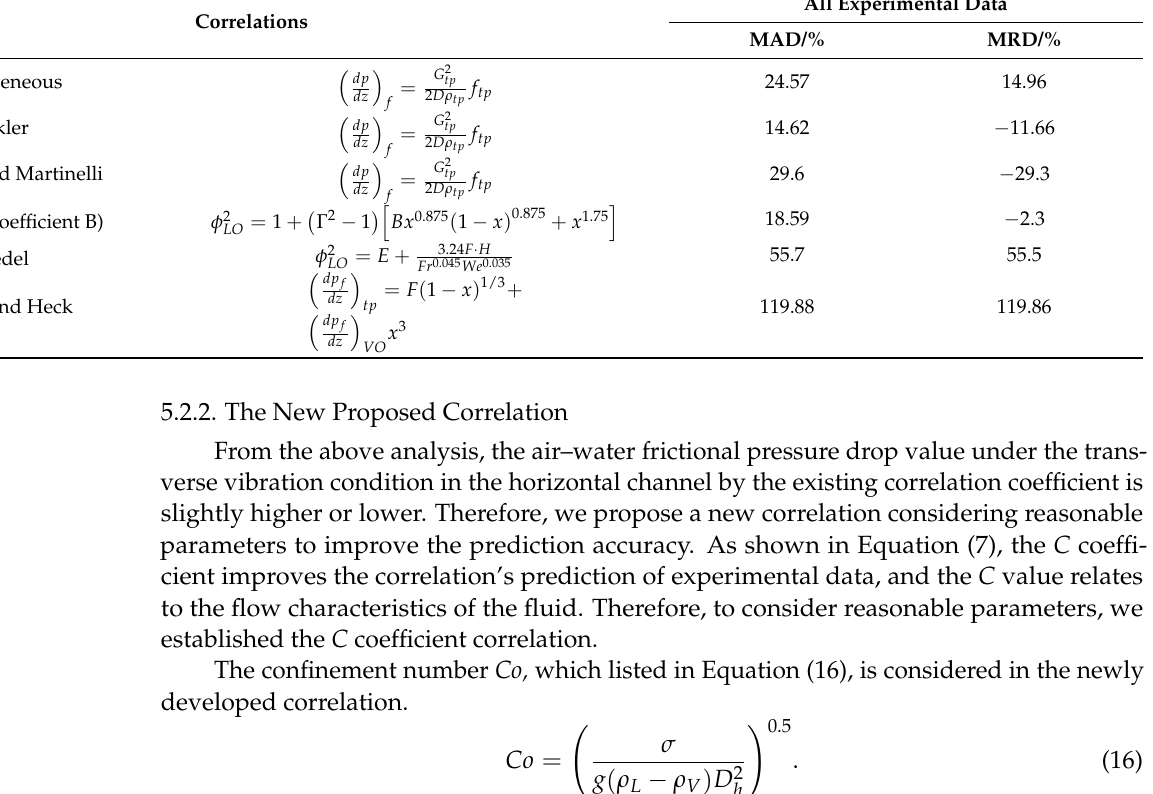
Table 3. The comparison between experiment results and these correlations. Correlations